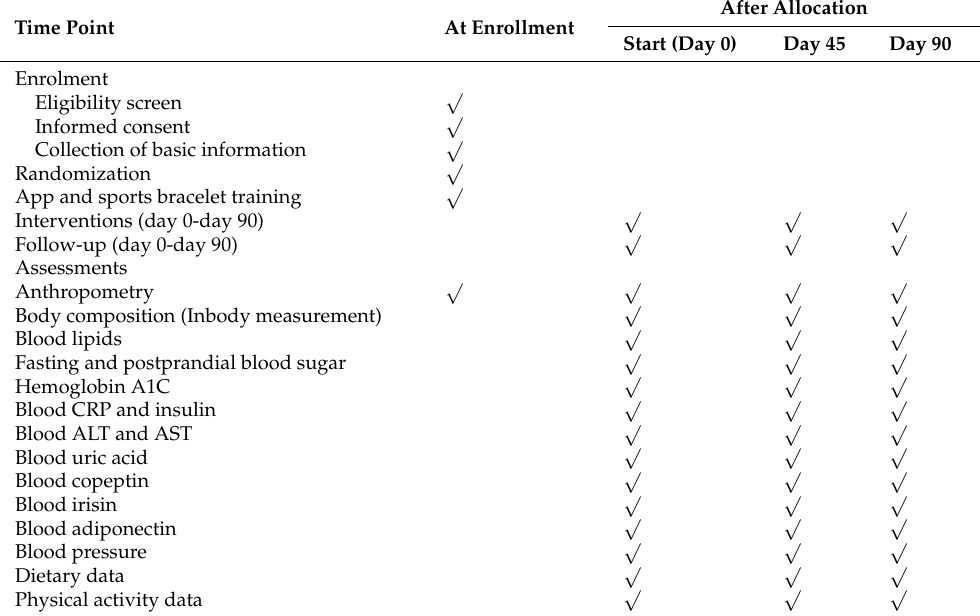
Table 1. Summary of the trial.